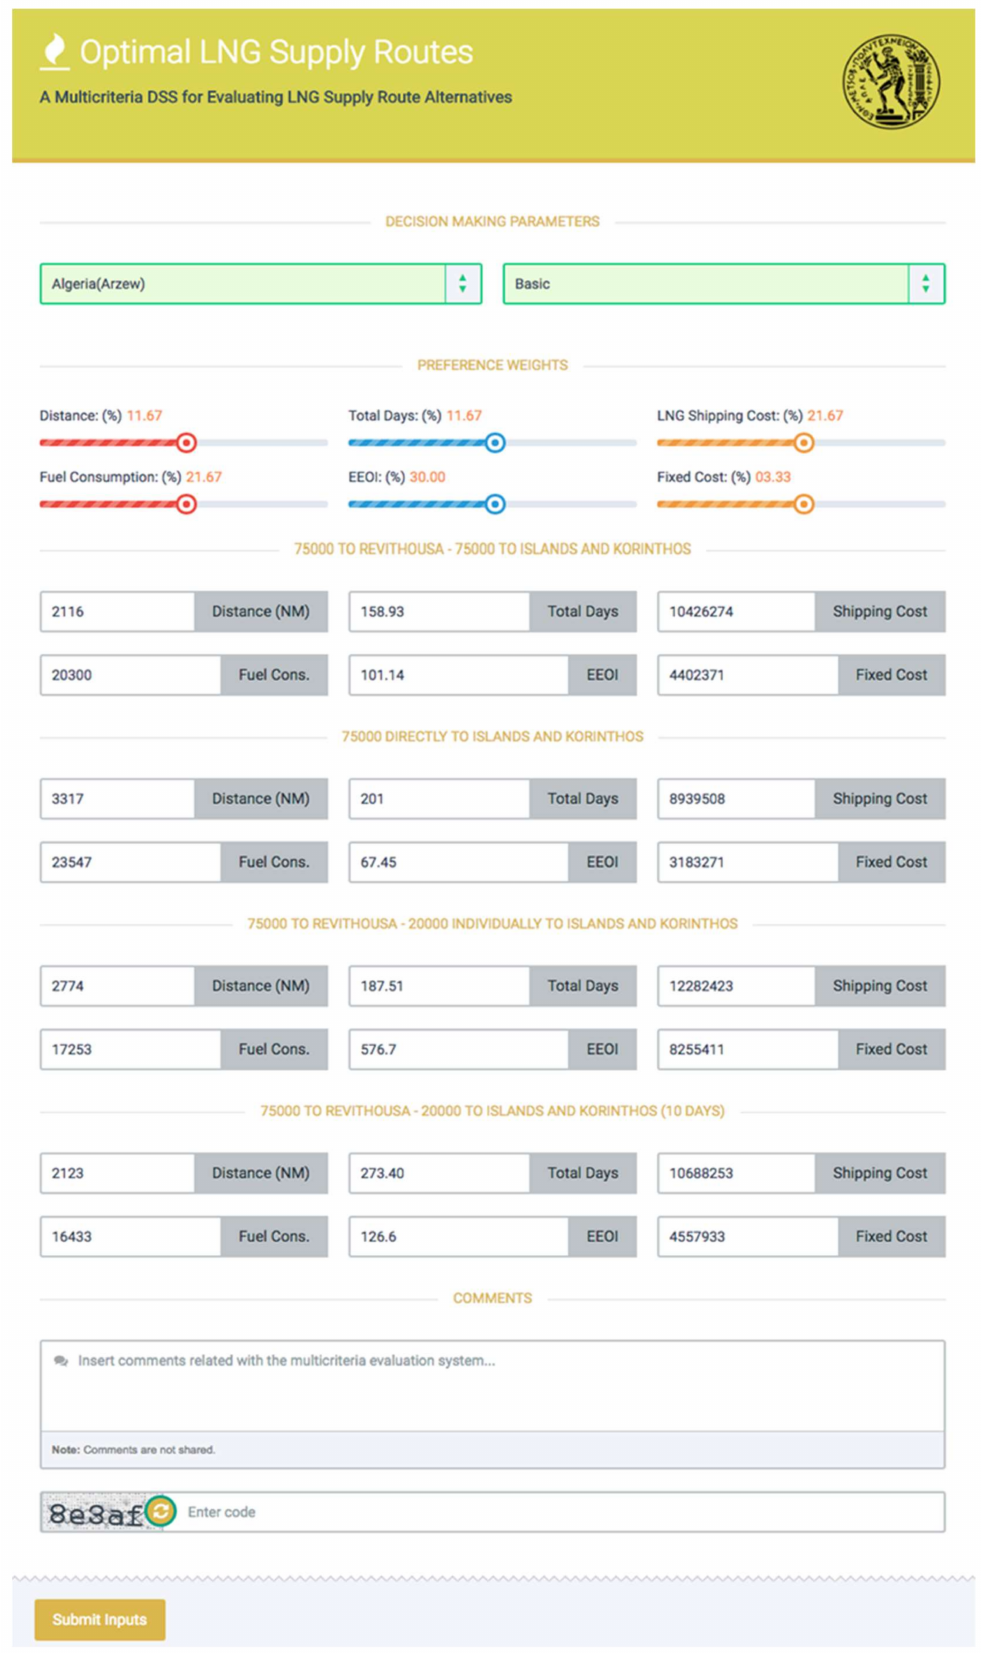
Figure 3. A screenshot of the developed decision support